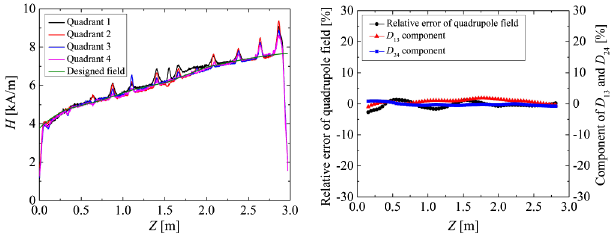
FIG. 20. Field distribution in the four quadrants (left), relative error of the quadrupole field, and dipole component (right) after tuning. (23.7°C, with nitrogen fed into the cavity).